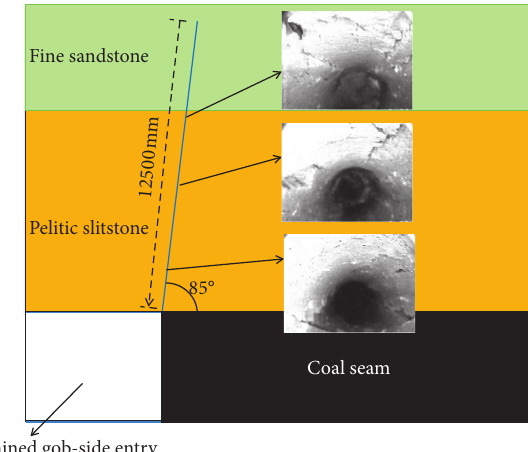
Figure 15: The arrangement and detection pictures of the borehole.